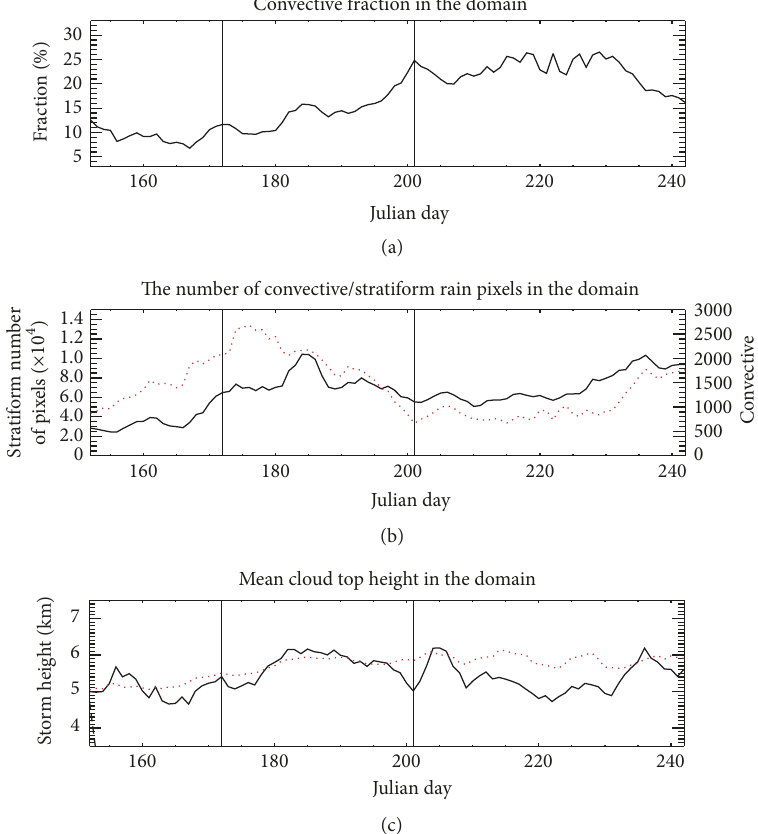
Figure 6: Climatological evolution of (a) convective fraction, (b) the number of convective and stratiform rain pixels, and (c) mean cloud top height in time (Julian day). The two vertical lines represent the beginning and end dates of the climatological period for Changma. Solid and dotted lines represent convective and stratiform rain clouds, respectively.